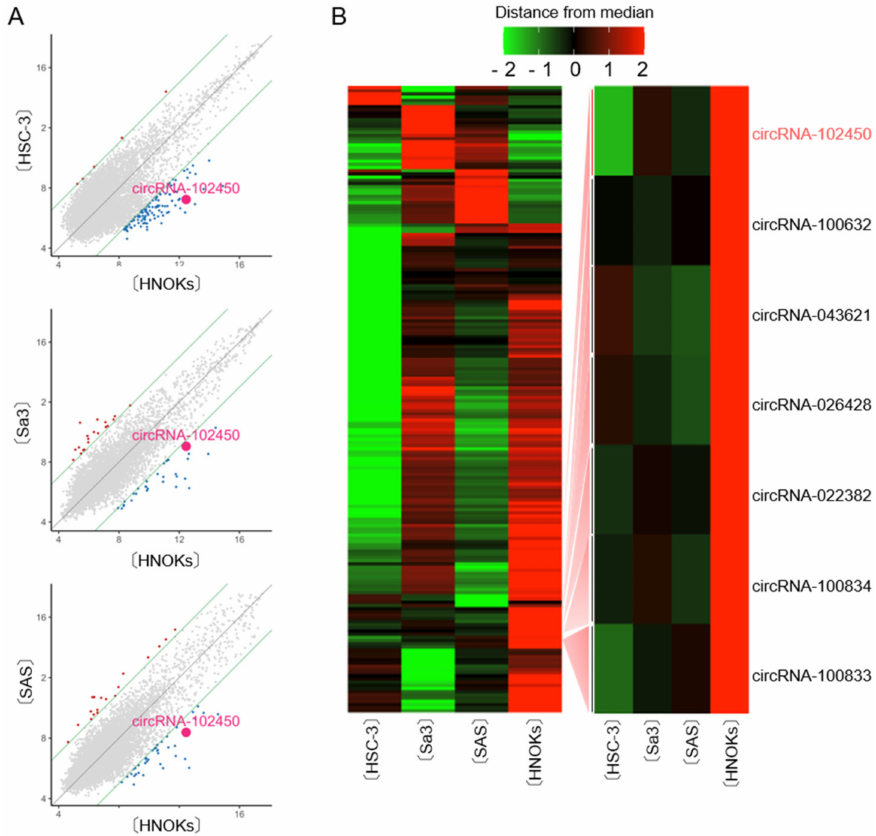
Figure 1. CircRNA microarray analysis in OSCC cells. ( A ) Scatter plot showing the variations in circRNA expression between the OSCC cell lines (HSC-3, Sa3, and SAS) and HNOKs. The circRNAs above the top green line and those below the bottom green line displayed a greater than 3.0-fold change in expression between the two samples compared. ( B ) Hierarchical clustering of circRNA expression profiles among the OSCC cells (HSC-3, Sa3, and SAS) and HNOKs. Red and green suggest high and low relative expression, respectively, in OSCC